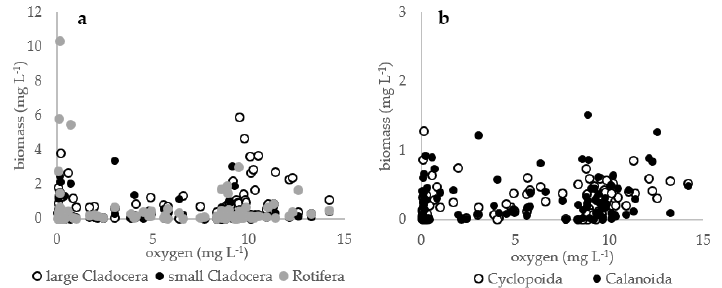
Figure 7. Biomass of Cladocera, Rotifera ( a ), and Copepoda ( b ) along oxygen concentration scales.